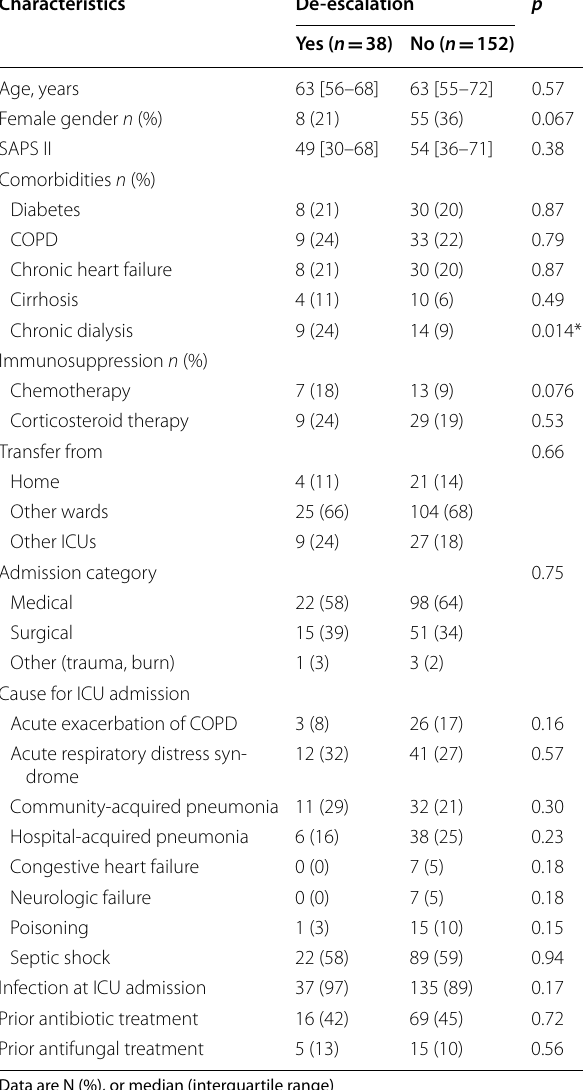
Data are N (%), or median (interquartile range) COPD chronic obstructive pulmonary disease, ICU intensive care unit, SAPS simplified acute physiology score * Odds ratio (95% confidence interval) 3.1